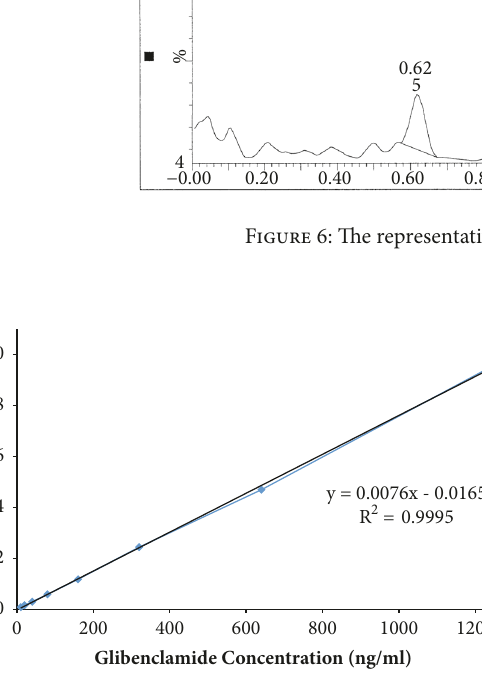
Figure 7: The calibration curve of glibenclamide in plasma.